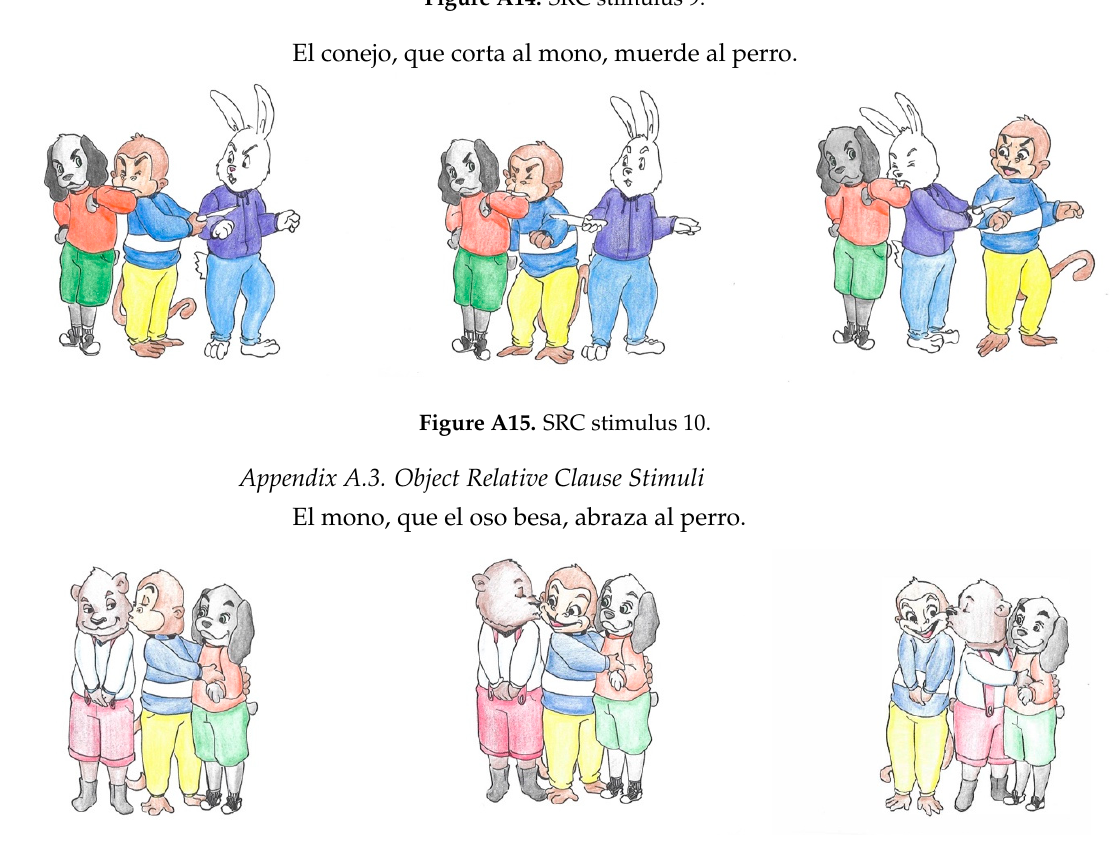
Figure A16. ORC stimulus 1.